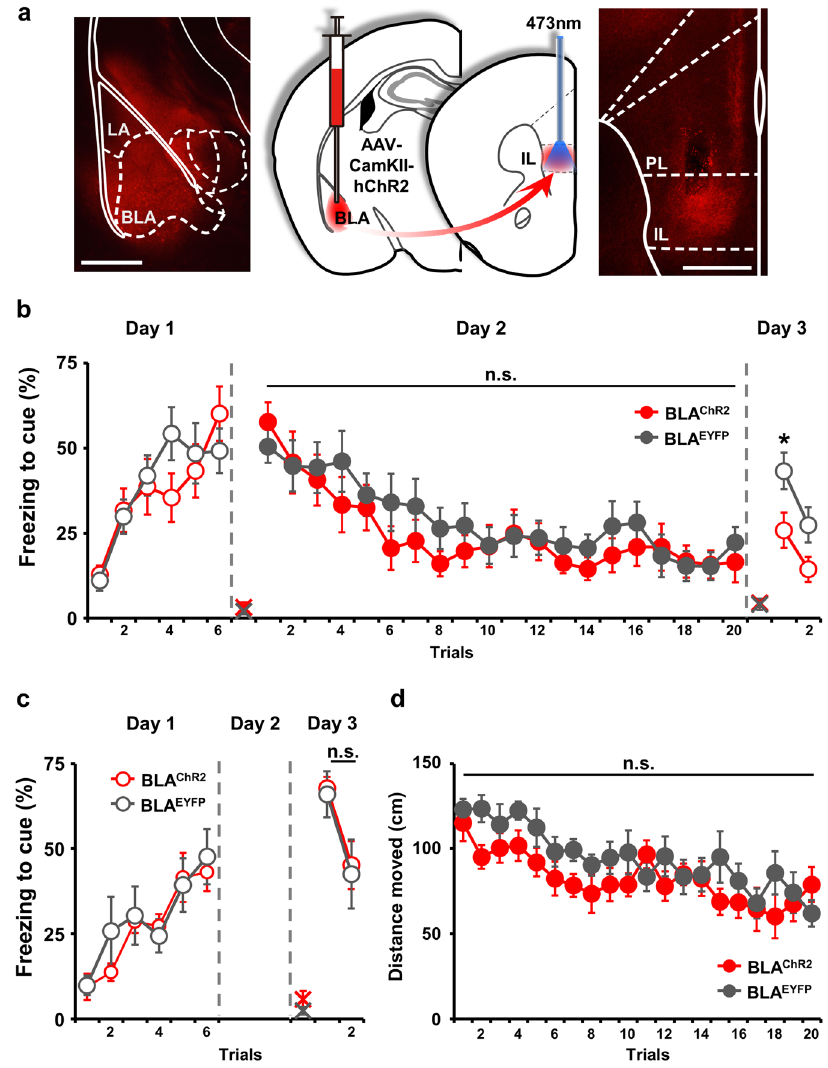
Figure 2. Stimulation of presynaptic input of the BLA during extinction training facilitates extinction memory without affecting freezing responses during extinction training. ( a ) Schematic representation of AAV2/9- CamKIIa-hChR2(H143R)-mCherry infection in the BLA and optic fiber placement in the IL. Scale bar: 500 μ m. ( b ) ChR2 stimulation of presynaptic input from the BLA to the IL during extinction training did not affect freezing responses to a tone on day 2, but facilitated extinction retrieval, measured as freezing responses on day 3 (BLA ChR2 , n = 10; BLA EYRP , n = 11). ( c ) Optic stimulation of presynaptic input from the BLA to the IL without extinction training did not affect freezing in retrieval tests (BLA ChR2 , n = 7; BLA EYFP , n = 7). ( d ) Optic stimulation of afferent projections from the BLA to the IL did not alter locomotion (BLA ChR2 , n = 7; BLA EYFP , n = 7). Data are presented as means ± s.e.m. Empty circle, absence of optic stimulation; filled circle, presence of optic stimulation; X, baseline freezing